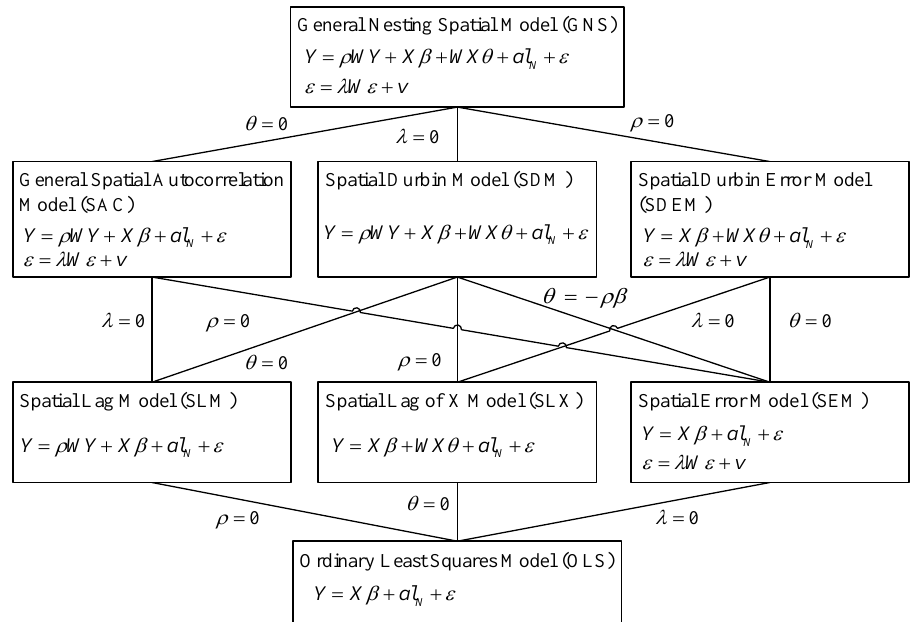
Figure 4. Relationship between different spatial autoregressive models. Due to over parameterization, the GNS model and the SAC model are very difficult to explain. Thus, they are rarely applied in empirical research [40]. Therefore, we do not discuss them in this